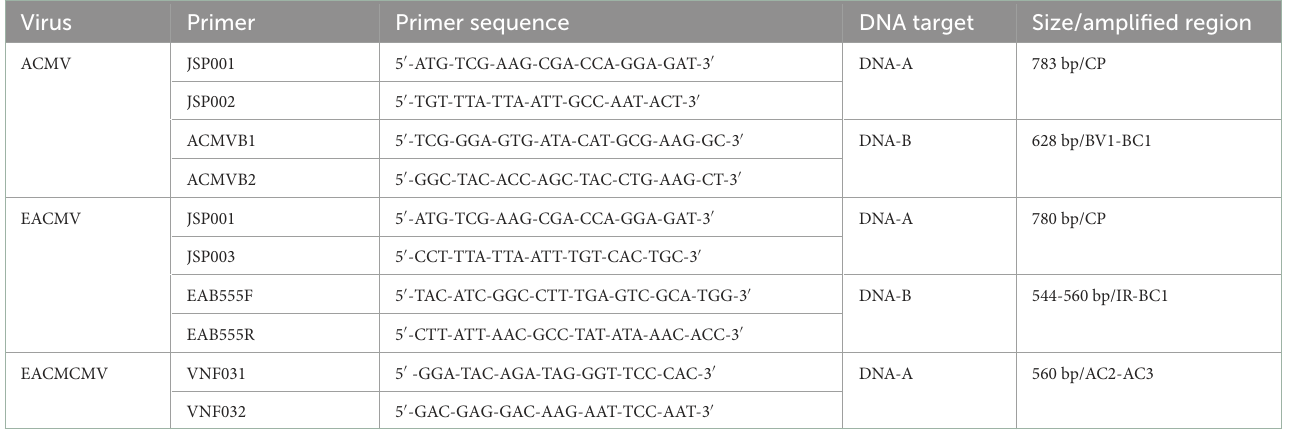
TABLE 2 PCR primer pairs for ACMV, EACMV, and EACMCMV detection.